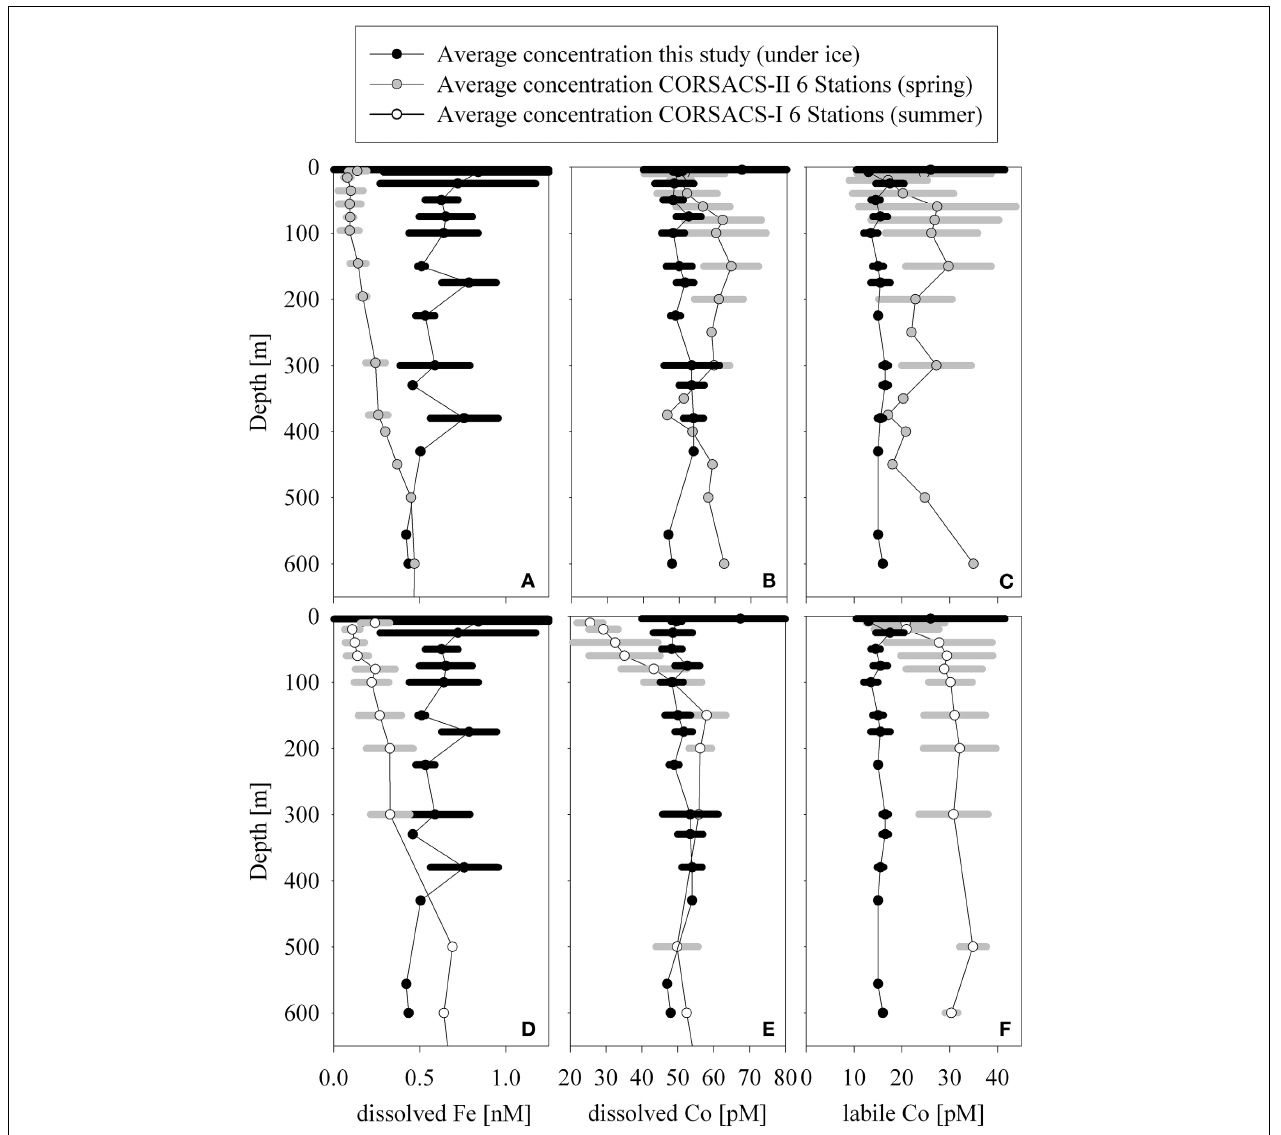
FIGURE 9 | Averaged profiles of dissolved iron (A,D), dissolved cobalt (B,E), and labile cobalt (C,F) from this study (all panels, Stations 1–3), the spring CORSACS study (A–C, Stations NX12–15, NX17, NX20; data from Saito et al., 2010; Sedwick et al., 2011), and the summer CORSACS study (D–F, Stations NX1–4, NX7, NX10; data from Saito et al., 2010; Sedwick et al., 2011). Stations from the CORSACS study were chosen based on proximity of station location to this study. A similarity between the